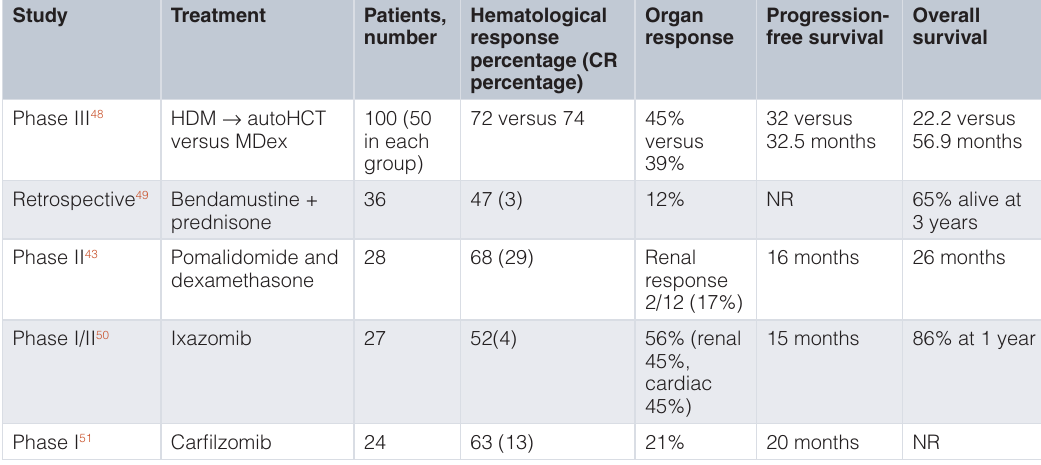
Table 2. Outcome of relapsed refractory amyloid light-chain amyloidosis with salvage treatment regimens.